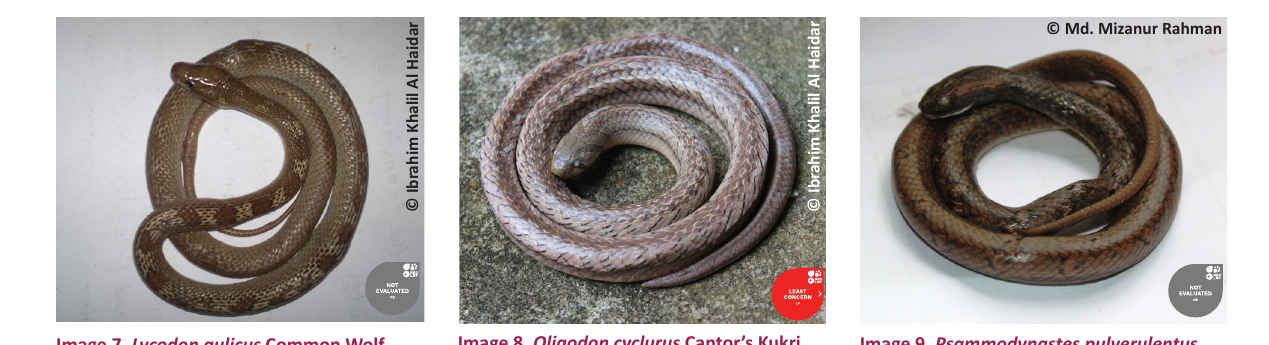
Image 7. Lycodon aulicus Common Wolf Snake